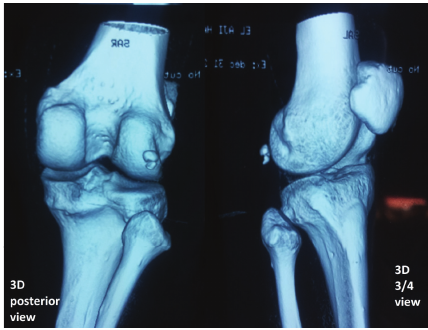
Figure 3: 3D-CT reconstruction revealed a fracture of the